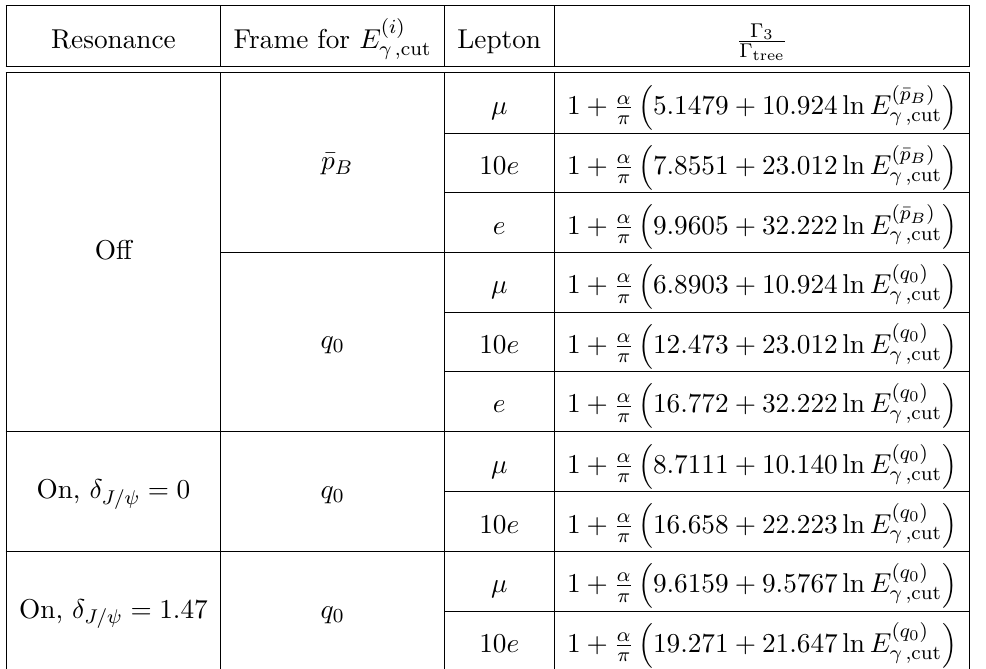
Table 3 . f th for different cases. When the resonance is “on”, the interference of the Breit-Wigner term of the J/ψ and the rare mode is included (but not the square of the Breit-Wigner term). 10 e is a ‘fake’ lepton that has an ‘intermediate’ mass (between the muon and the electron), and we take m 10 e = 10 m e . When the resonance is “off” (ie. only rare mode), the full range of q 2 over. When δ = 0 , the q 2 integration is restricted in the region q 2 J/ψ 0 when δ = 1 . 47 , the q 2 integration is restricted in the region q 2 J/ψ 0 GeV